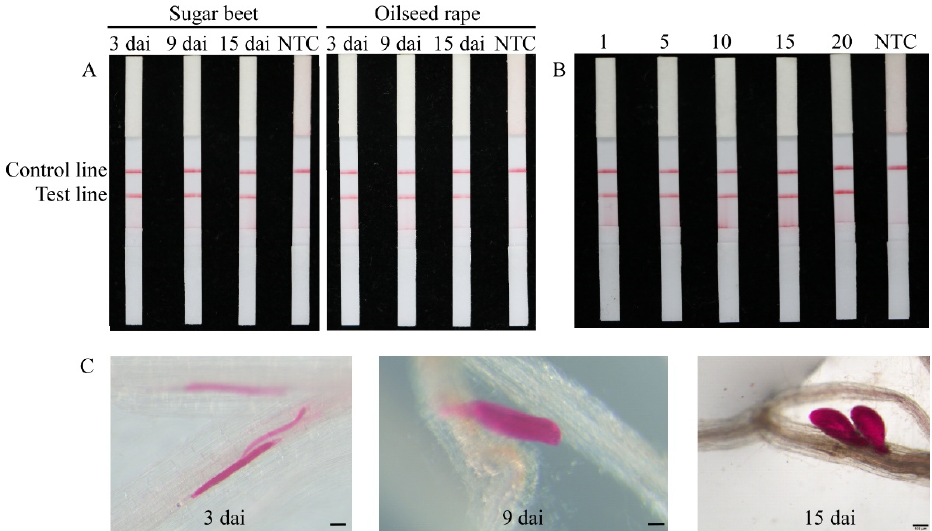
Figure 5. Application of the RPA system for direct detection of H. schachtii in soil and plant samples. ( A ) H. schachtii in sugar beet and oilseed rape roots. ( B ) H. schachtii in soil. ( C ) Morphology of H. schachtii in sugar beet roots on various days after inoculation, bar = 100 µm. NTC, no template was added as a negative control. The presence of two lines, including a control line and test line, indicates a positive result.